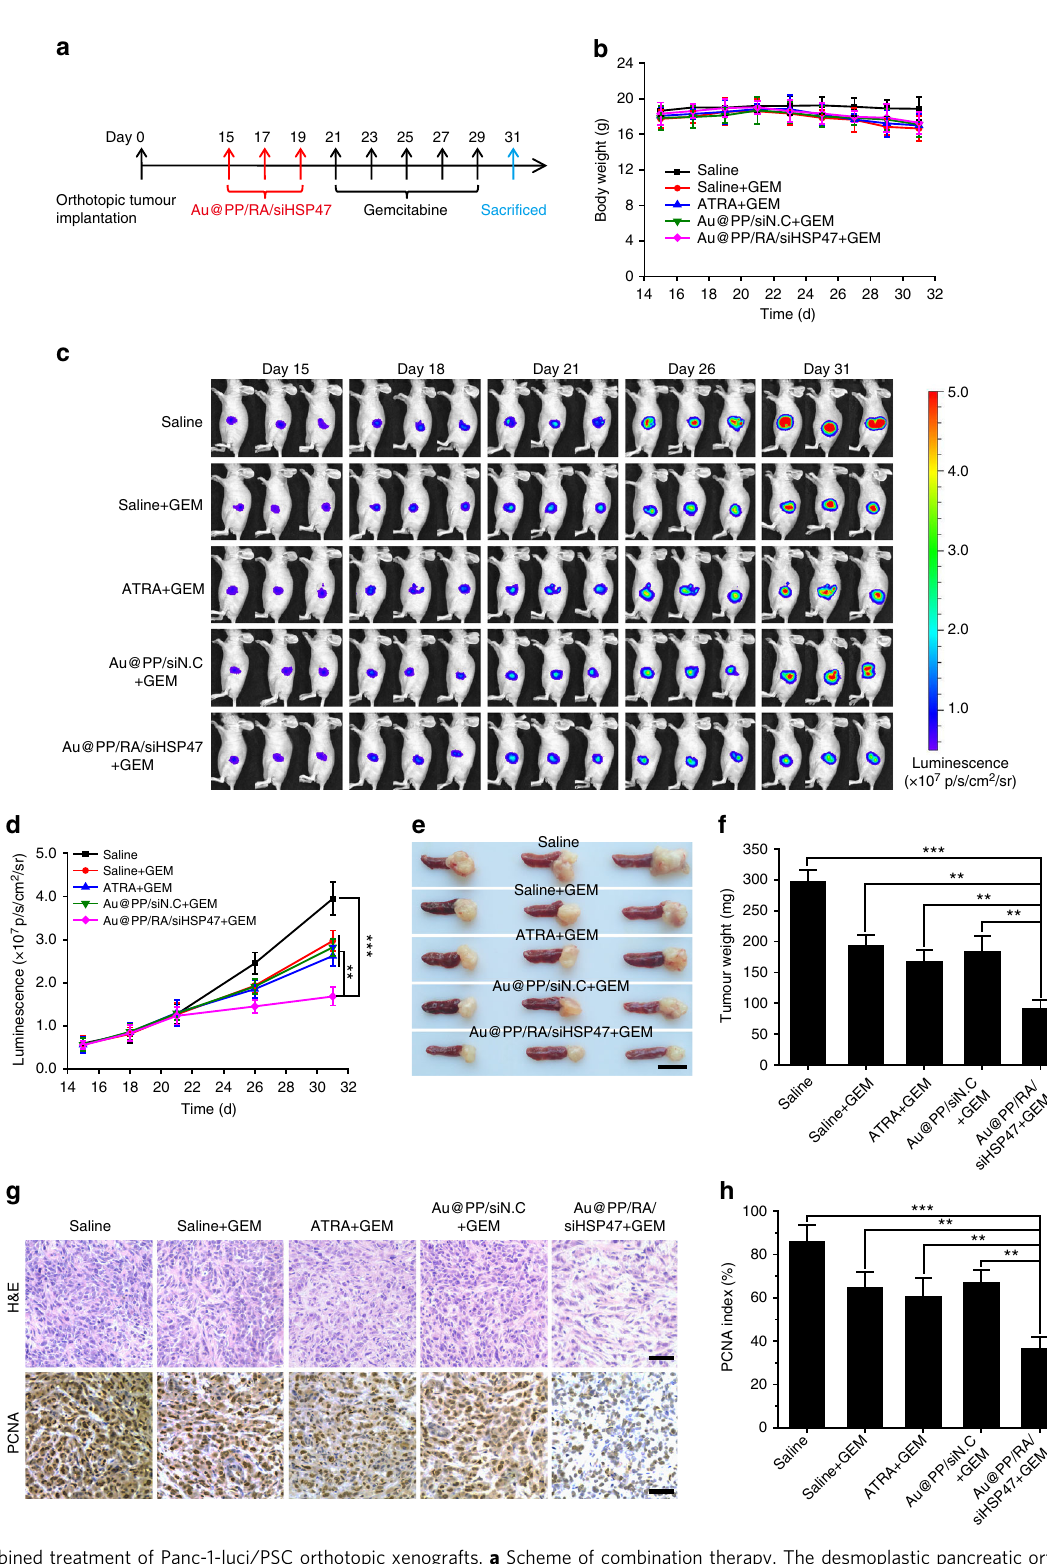
Fig. 9 Combined treatment of Panc-1-luci/PSC orthotopic xenografts. a Scheme of combination therapy. The desmoplastic pancreatic orthotopic xenografts were established by co-inoculation of luciferase-expressing Panc-1 cells (Panc-1-luci) and PSCs into the pancreatic tails of BALB/c nude mice. The mice received Au@PP/RA/siHSP47 intravenously every 2 days for three injections and subsequently received gemcitabine intravenously every 2 days for fi ve injections. b Body weight changes of mice during treatment. c In vivo whole-body bioluminescence images of mice on days 15, 18, 21, 26 and 31. d Tumour growth curves as determined by quanti fi cation analysis of the in vivo bioluminescence signal. e Image of excised tumours with spleens. Scale bar, 1 cm. f Tumour weights after treatment. g Histological studies with H&E and immunohistochemical staining of PCNA in tumour sections. Scale bars, 50 μ m. h Quanti fi cation of PCNA-positive tumour cells. The data are shown as the mean ± s.d. ( n = 3). ** p < 0.01, *** p < 0.001 (Student ’ s t